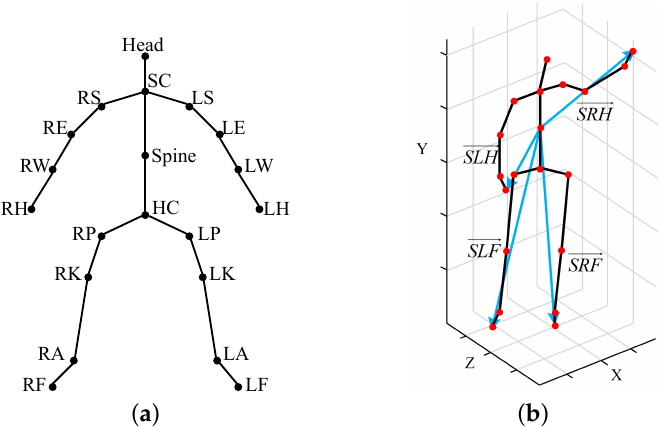
Figure 3. Human skeleton. ( a ) Skeleton; ( b ) The skeletal frame of the high